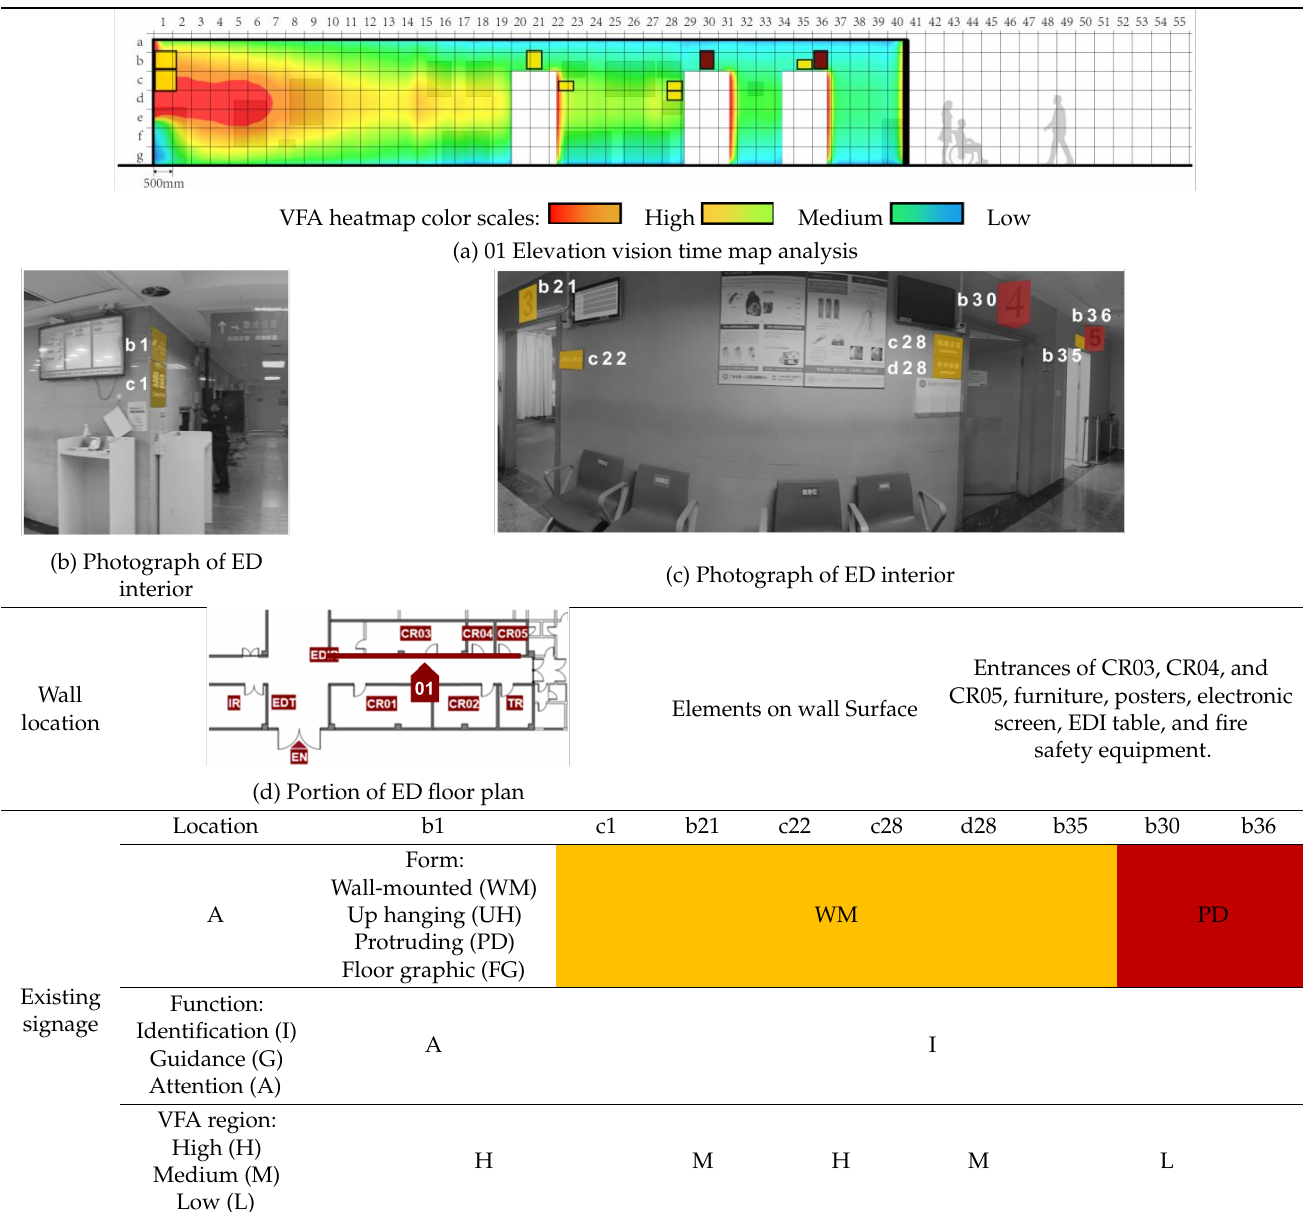
Table 5. 01 Elevation comparative